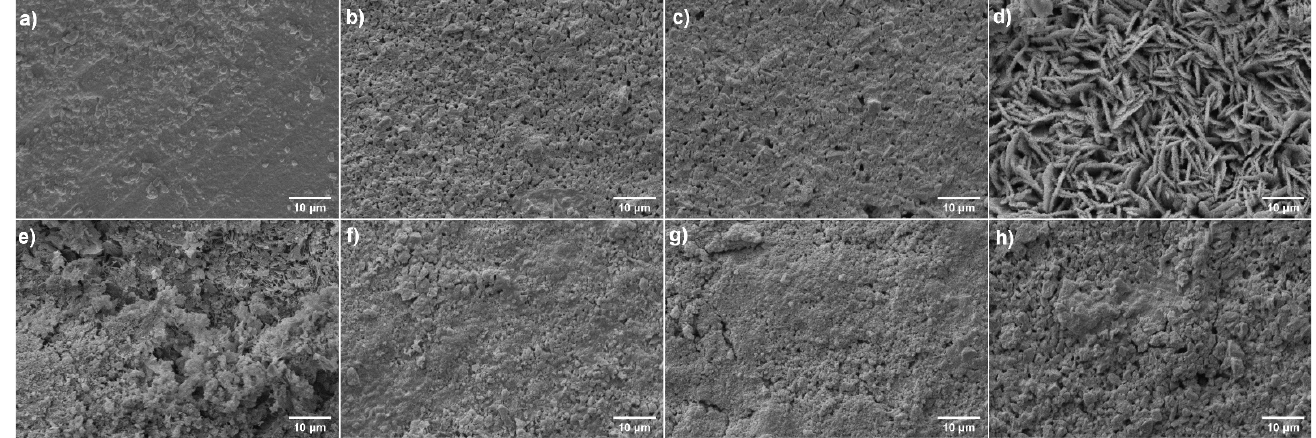
Figure 3. SEM images (magnification 1500×) of Wave samples: ( a ) control, ( b ) H 2 O, ( c ) NaCl, ( d ) AS pH 4.5, ( e ) AS pH 4.5, ( f ) AS pH 5.5, ( g ) AS pH 7.0, ( h ) AS pH 7.5.